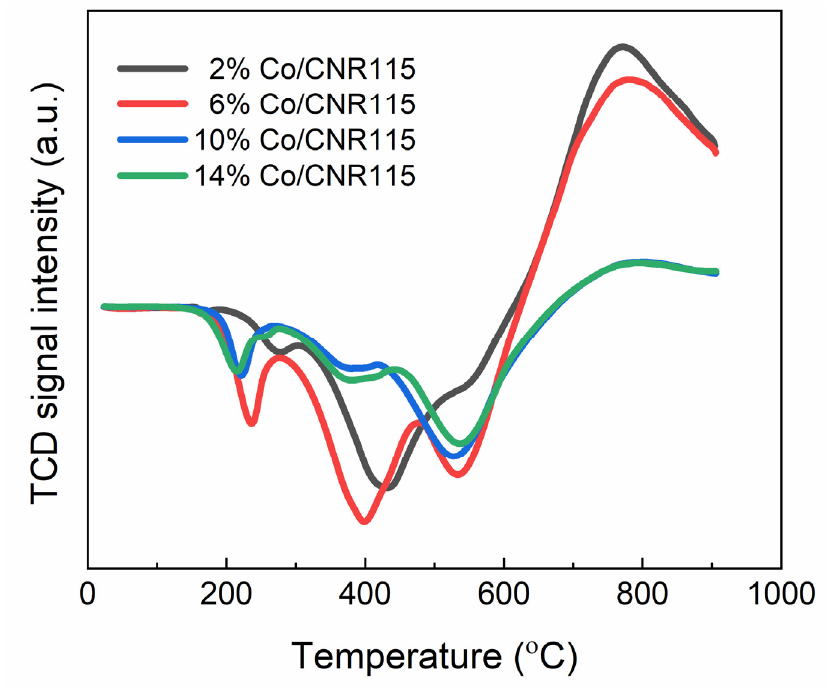
Figure 1. Temperature-programmed reduction of 2, 6, 10 and 14 wt.% Co/CNR115 after incipient wetness impregnation.